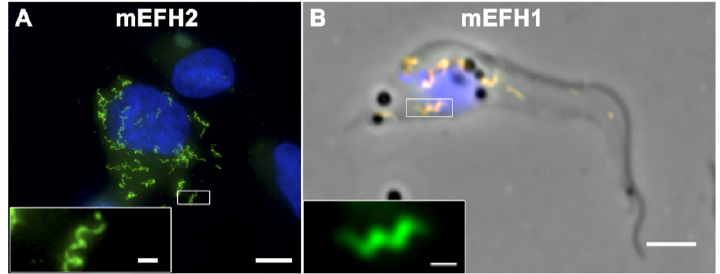
Figure 4. The effects of mutated Tb BILBO1 expression in a mammalian system and in T. brucei . ( A ) Immunofluorescence labeling of Tb BILBO1 carrying a mutation in EF hand 2 (mEFH2:myc) expressed for six hours in U-2 OS cells and probed using anti-NTD antibody. This mutated protein produces helical and ring shaped polymers. The inset shows a higher magnification of the boxed region. Scale bar: 10 μ m; scale bar in magnified inset: 1 μ m. ( B ) Immunofluorescence labeling of a T. brucei procyclic cytoskeleton expressing Tb BILBO1 carrying a mutation in EF hand 1 (mEFH1:myc). This mutation induces helical polymers. Cells were probed with anti-NTD antibody (green) and anti-myc (red) after 24 hours of induction, and the images were merged. The inset shows the anti-NTD label alone. Scale bar: 5 μ m; scale bar in magnified inset: 1 μ m. Reproduced from [44].